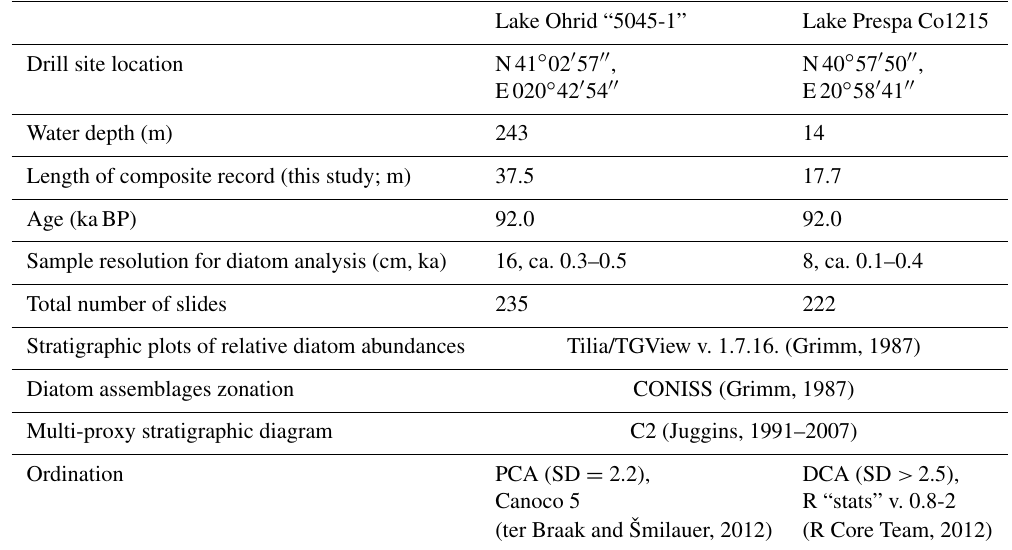
Table 1. Locations, sediment recovery and summary of methods used for the diatom analyses of cores 5045-1 from Lake Ohrid and Co1215 from Lake